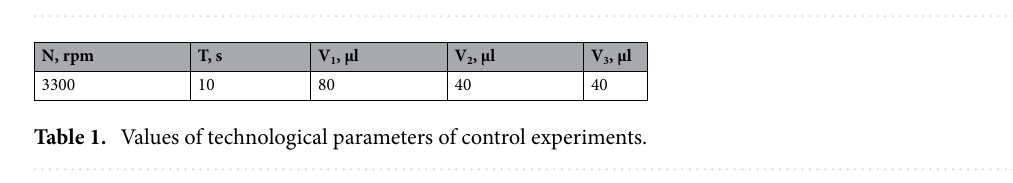
Figure 7. (a) Plot of dependence of substrate coverage area by monolayer and bilayer of PS nanospheres on spin-coating time; (b–d) microphotographs of nanosphere coatings obtained at varying spin-coating time.